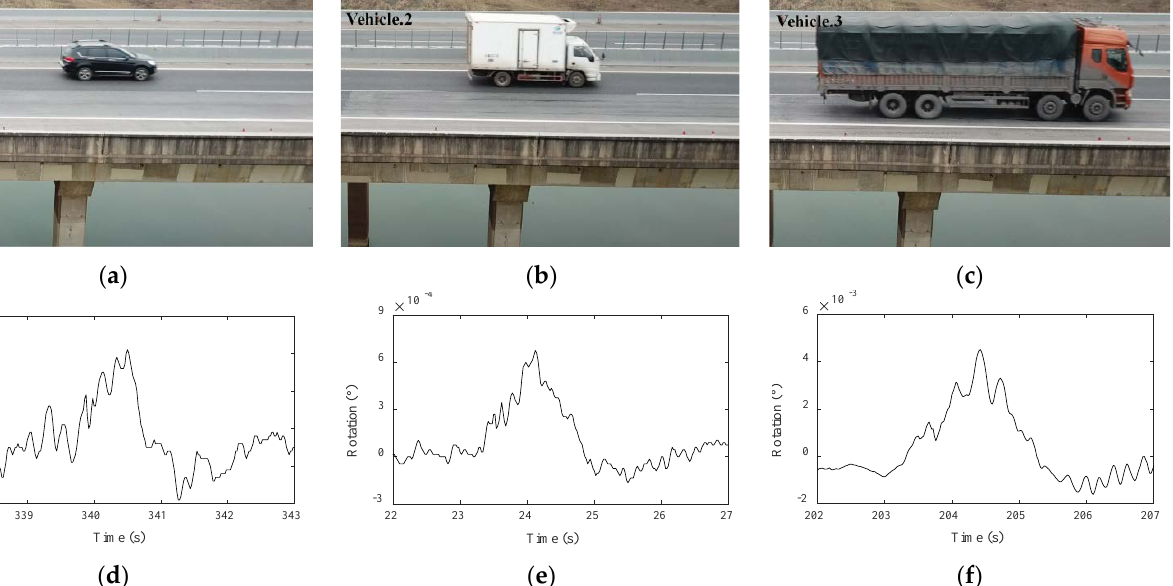
Figure 15. Beam-end rotation monitoring data under different vehicle loads ( a ) small vehicle; ( b ) medium vehicle; ( c ) large vehicle; rotation response to ( d ) small vehicle; ( e ) medium vehicle; ( f ) large vehicle. Table 3. Rotation responses generated by different types of vehicles. Vehicle Size